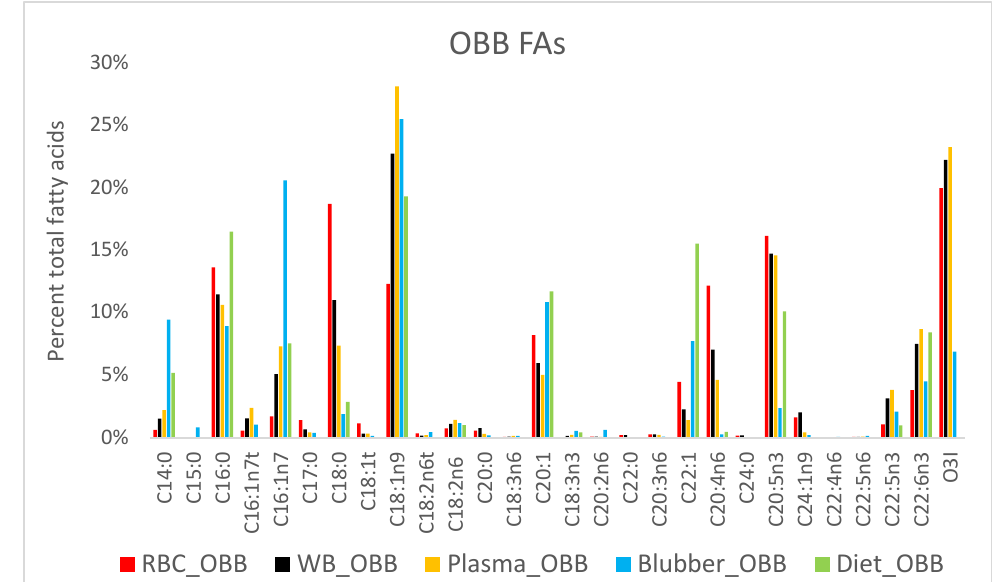
Figure 4. FA profiles from Oceanaria-based belugas (OBB, n = 4) by tissue compartment (RBC, WB, plasma and blubber) and diet.